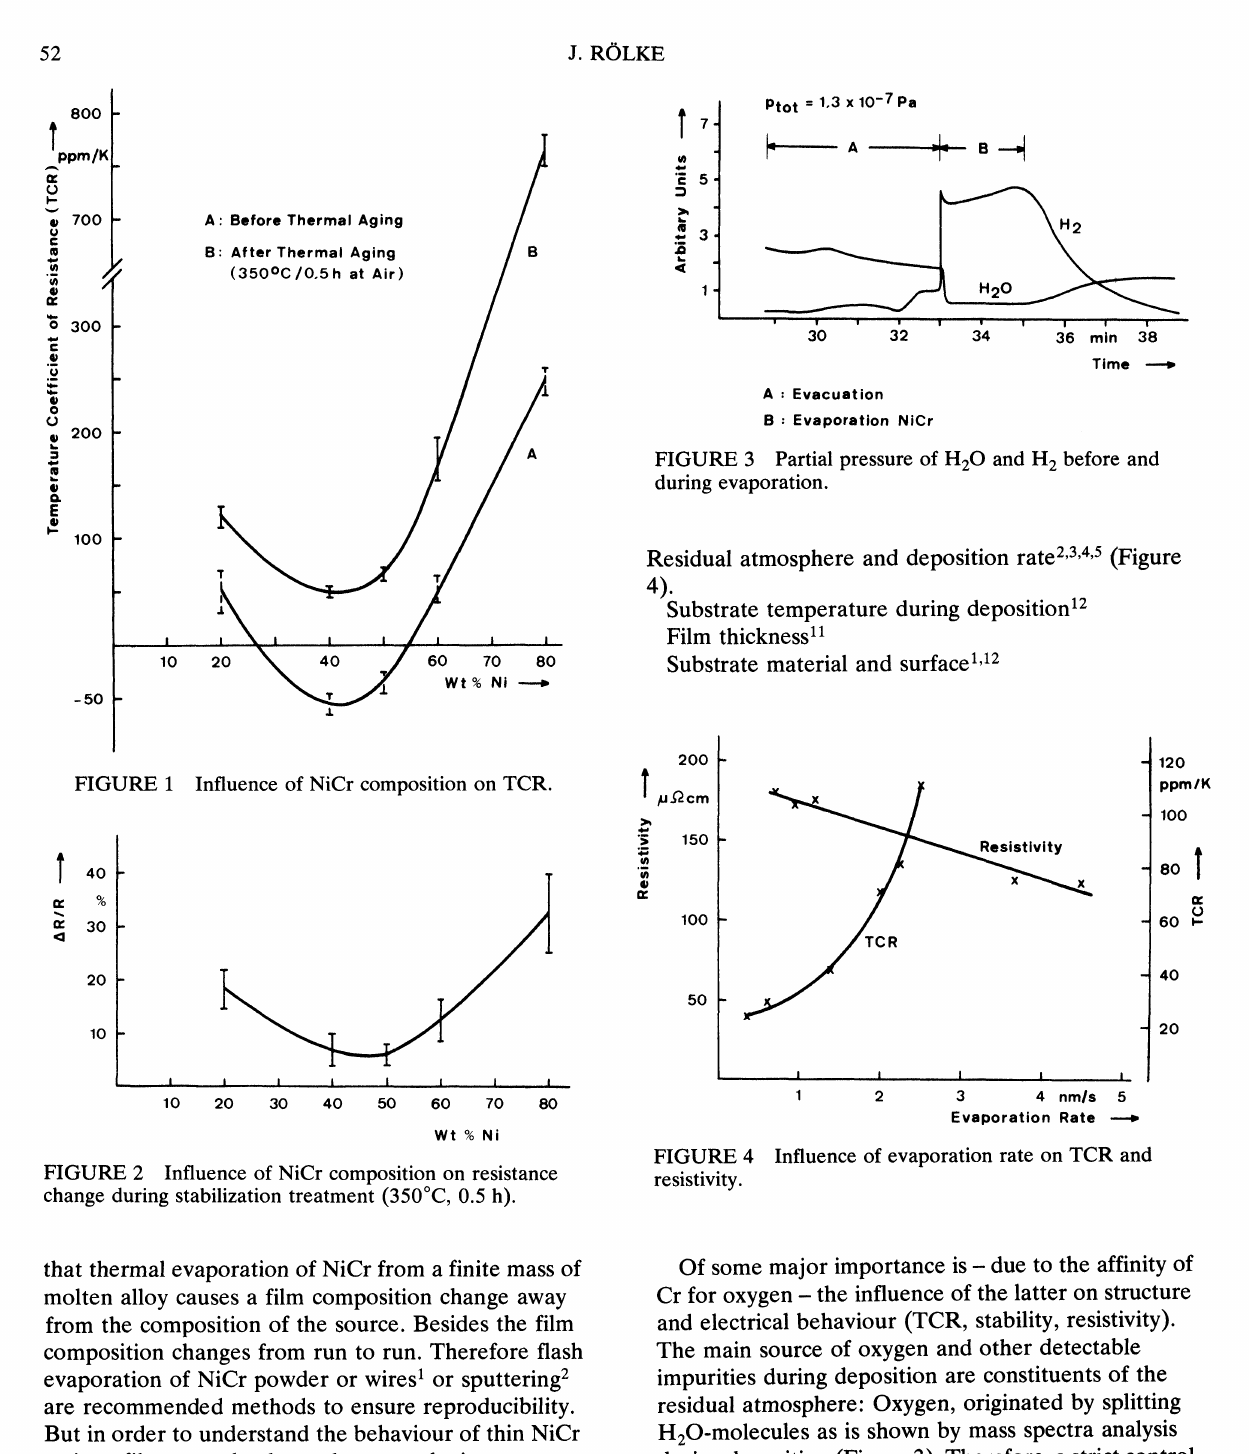
FIGURE 4 Influence of evaporation rate on TCR and